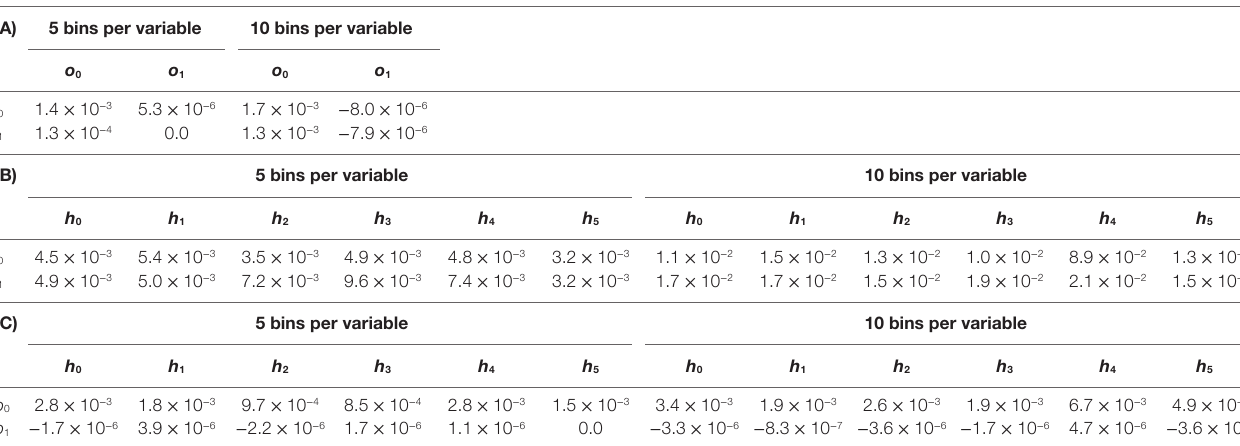
TaBle 2 | Mutual information between the states of nodes of the ann of T_0_9. (a) 5 bins per